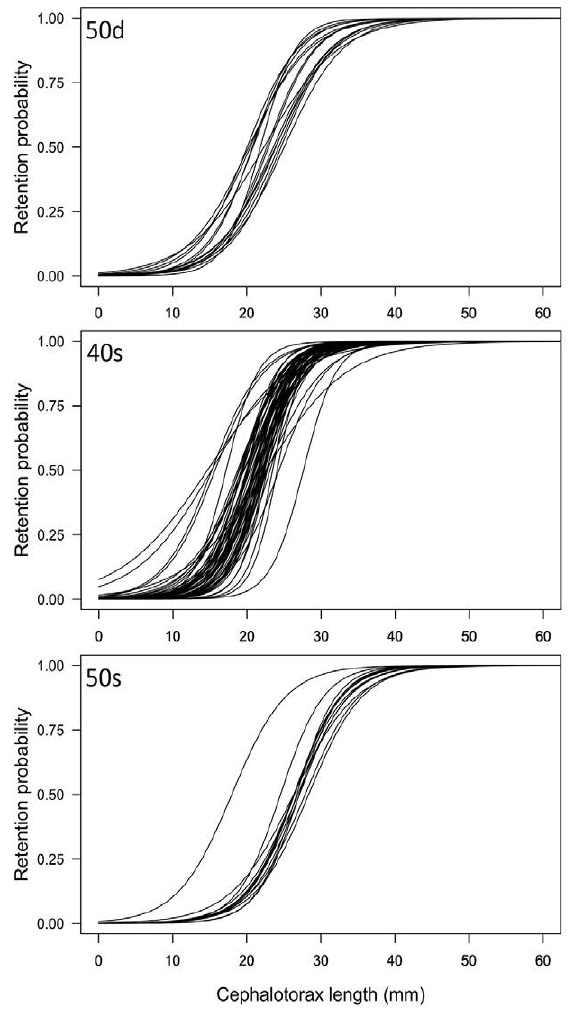
Fig. 4. – Selectivity curves of individual hauls for the 50-mm di- amond mesh (50d), 40-mm square mesh (40s) and 50-mm square mesh (50s).